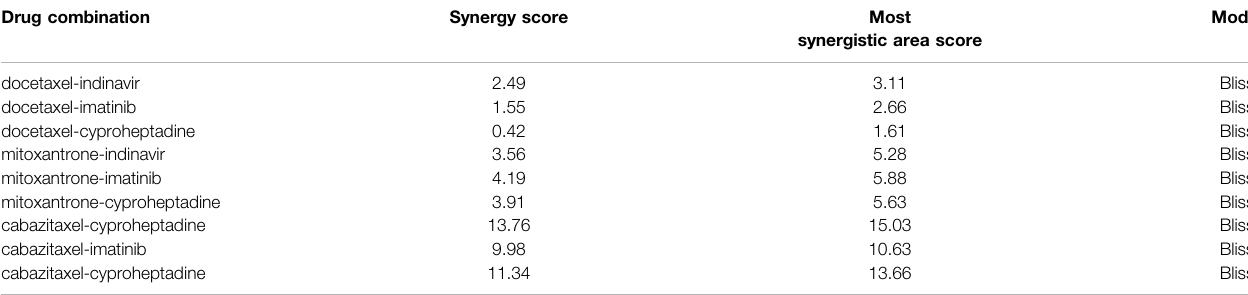
TABLE 1 | Synergy scores for each drug combination according to Bliss model. Drug